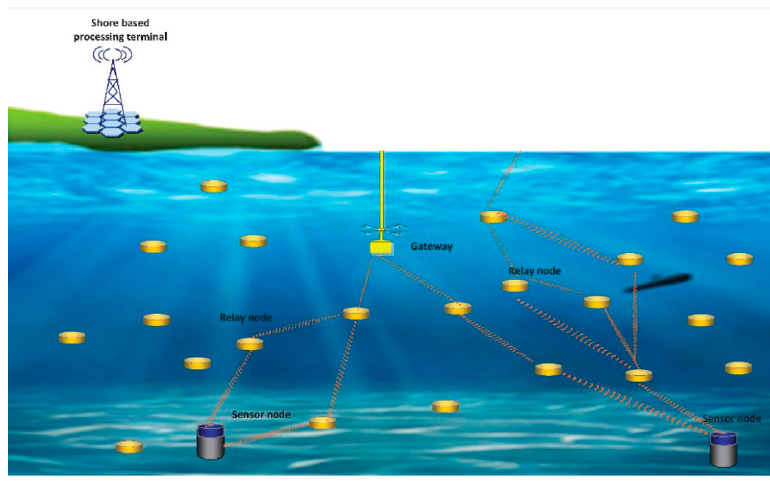
Figure 1. Schematic view of underwater sensor deployment [3].